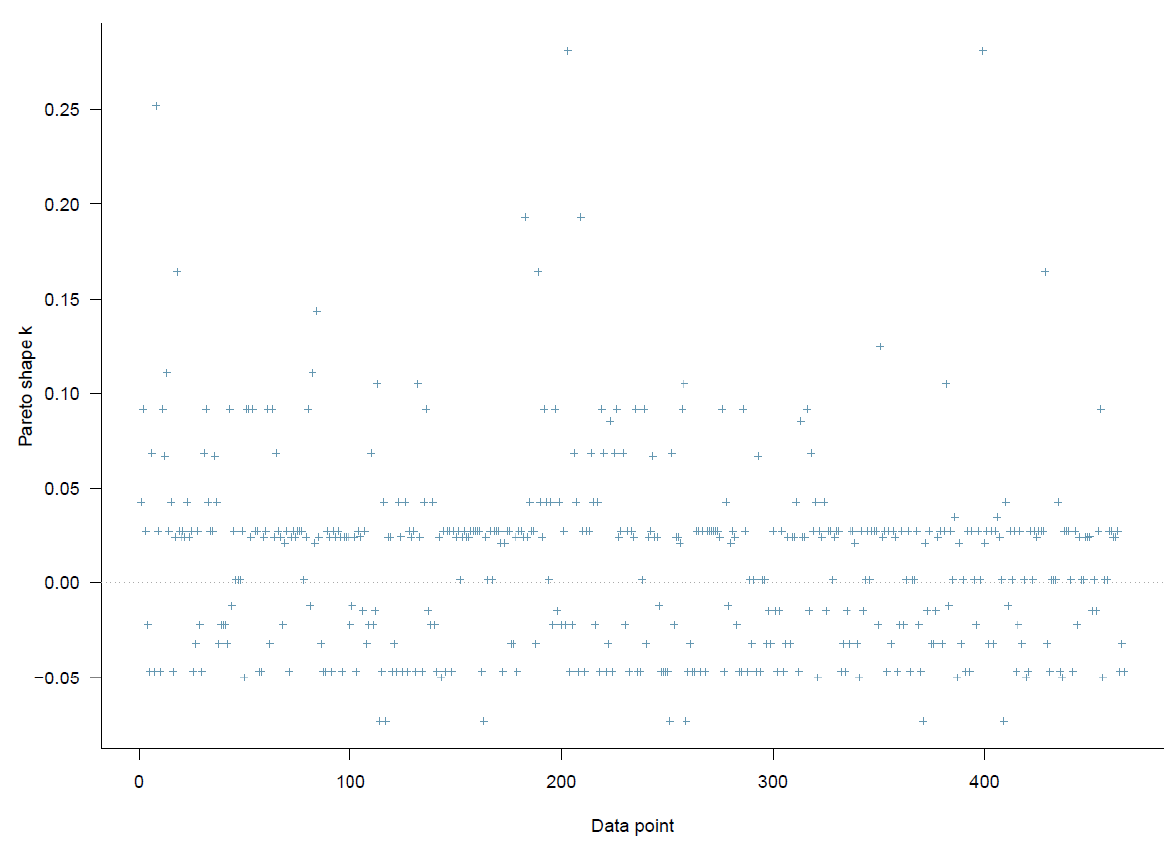
Figure 2. Model 1 ′ s PSIS diagnostic plot. Figure 2. Model 1 (cid:48) s PSIS diagnostic plot. Table 2. Model 1 (cid:48) s simulated